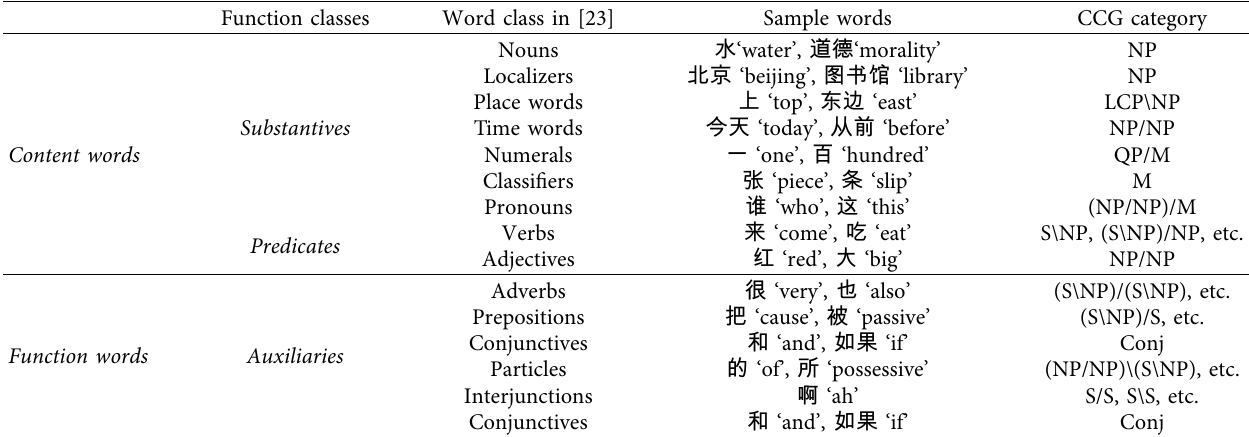
Table 7: Three-way function class distinction.